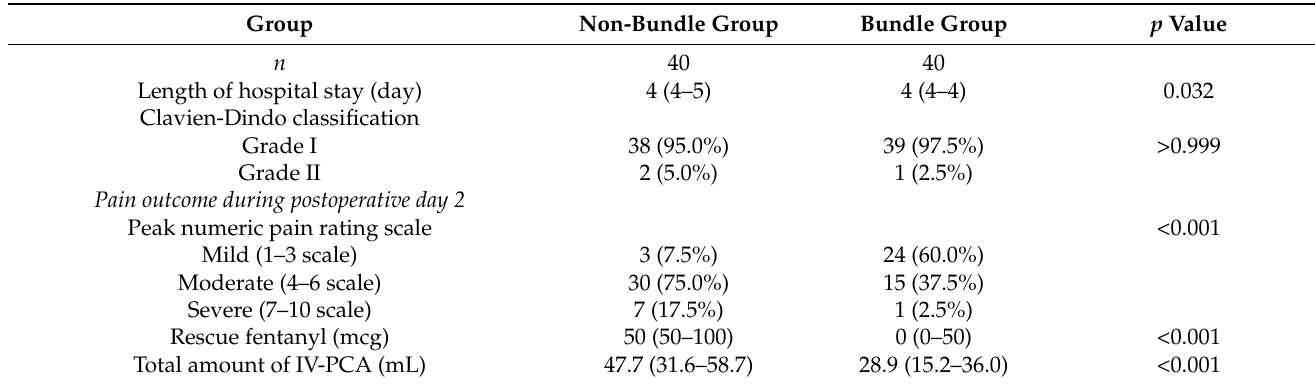
Table 3. Comparison of postoperative surgical and analgesic outcomes between the two groups.